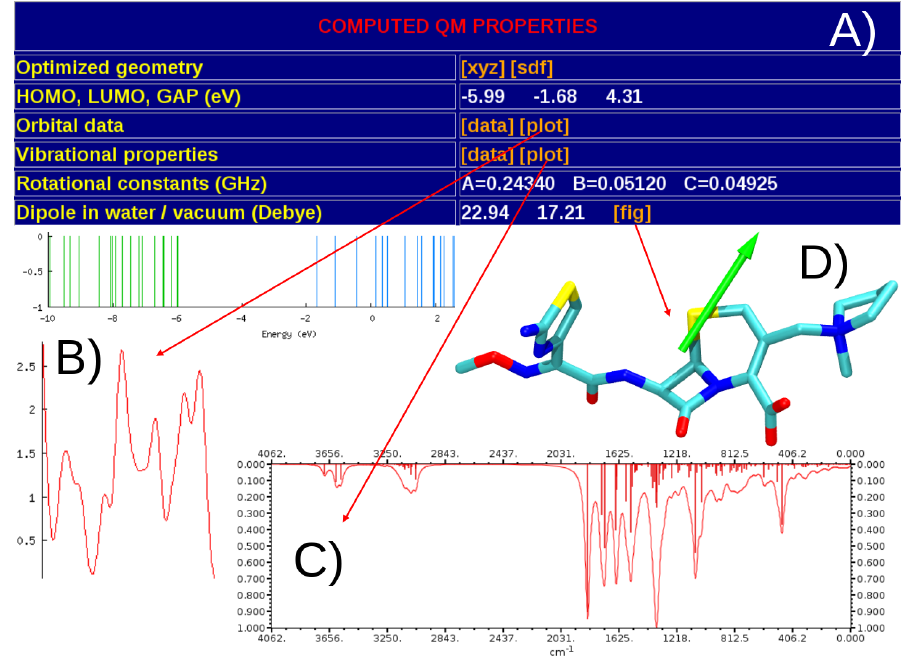
Figure 4. Snapshots of the list of molecular properties exctracted from QM calculations ( A ); the electronic ( B ); and vibrational spectra ( C ); and the visual representation of the electric dipole moment ( D ).